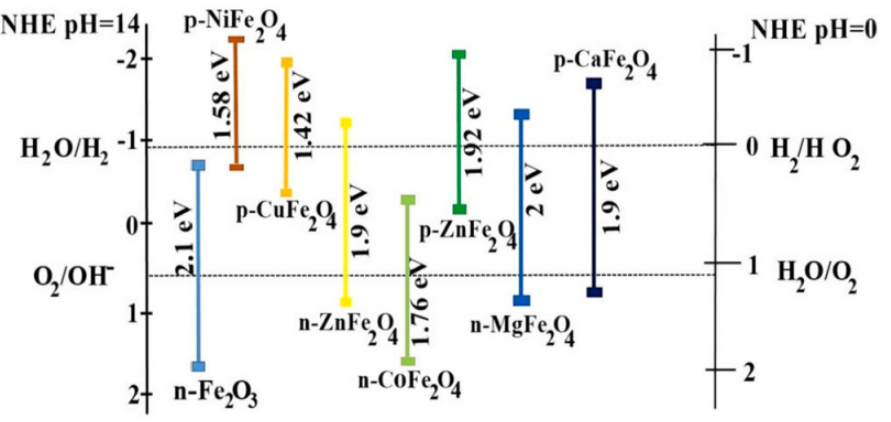
Figure 4. Bandgap energies of spinel ferrites (NHE, pH = 0 and 14). Reprinted with permission from [72] . Copyright (2021) Elsevier. Table 1. Summary of photocatalytic activity on spinel ferrites.